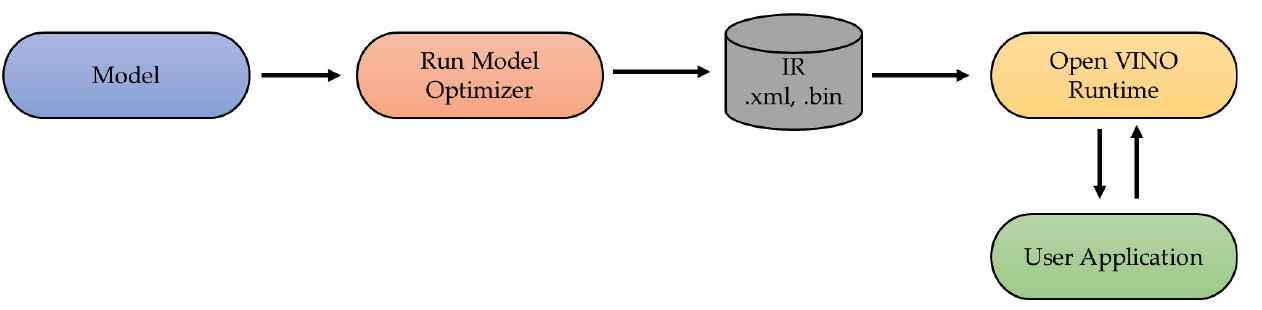
Figure 6. Block diagram for the optimisation and implementation with Intel OpenVino.